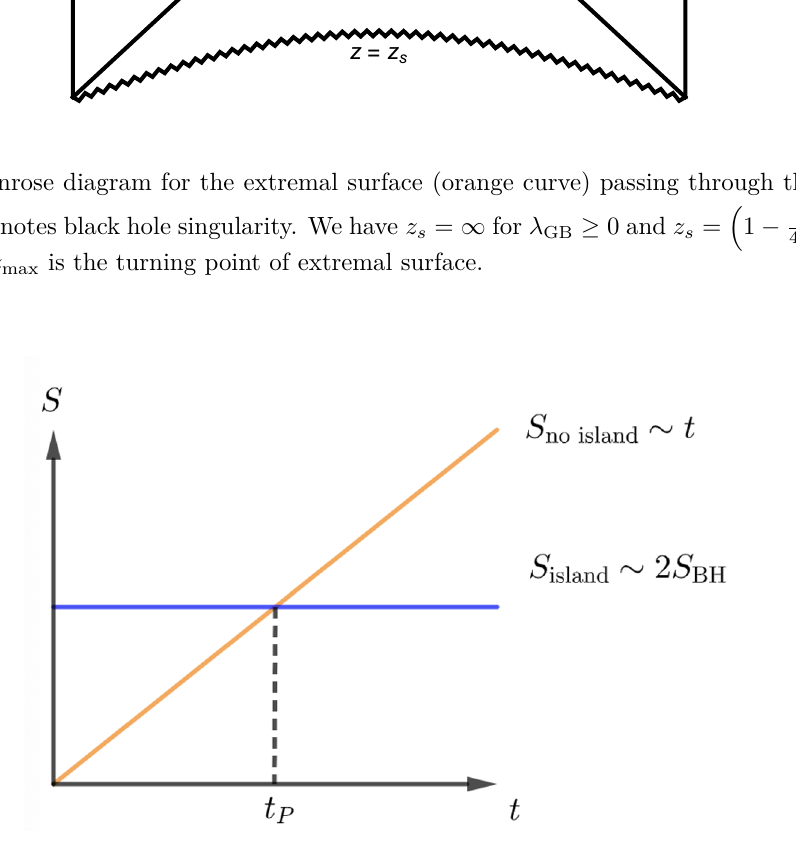
Figure 8 . Page curve for eternal two-sided black hole is combined by the orange curve when t < t P and the blue curve when t ≥ t P , where t P is the Page time. Without island, entanglement entropy of Hawking radiation will grow linearly in time after a few thermal times (orange curve). It will exceed twice the black hole entropy and lead to a paradox. The paradox can be resolved by the blue curve (island), which is due to the extremal surface outside the